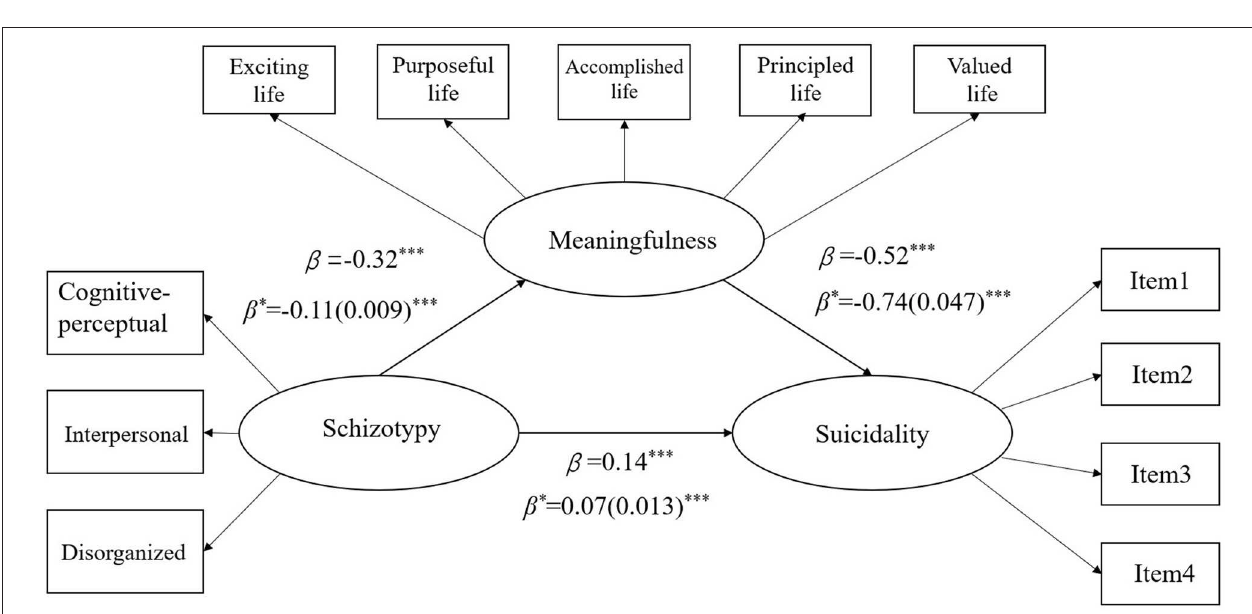
FIGURE 2 | Mediation model for relationship among schizotypy, meaningfulness, and suicidality in all samples. *** p < 0.001, β , standardized coefficients; β * , unstandardized coefficients; SE, standard errors in brackets.